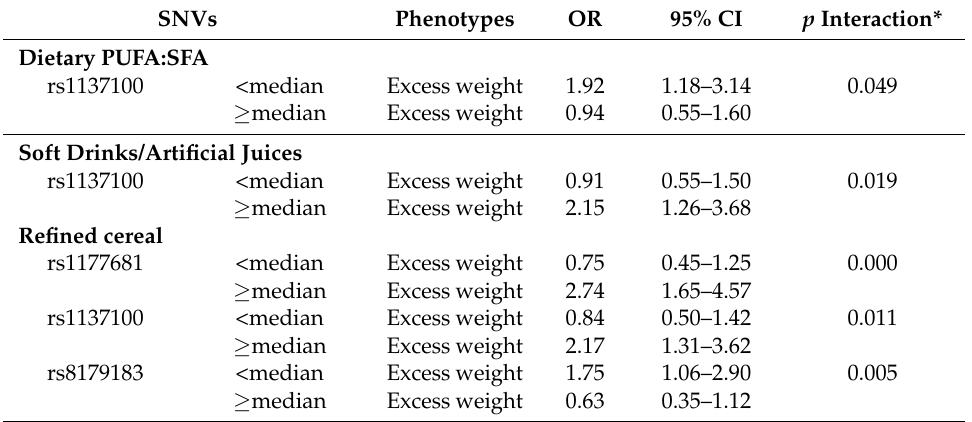
Table 4. Association between LEPR gene variants and excess weight according to food consumption. Salvador, Bahia, Brazil,